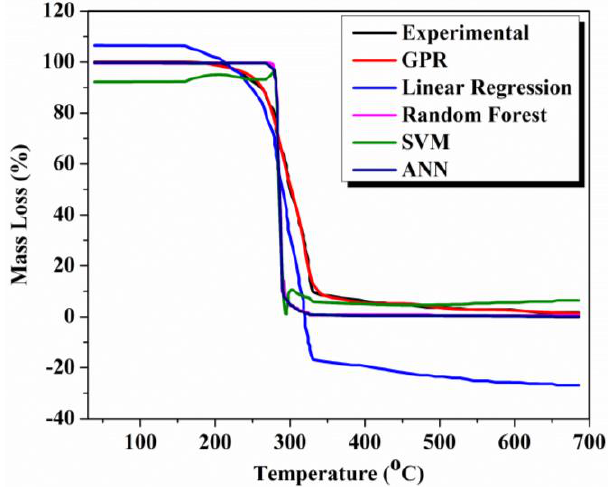
Figure 13. Comparison of experimental TGA curves with developed predicted machine learning models.